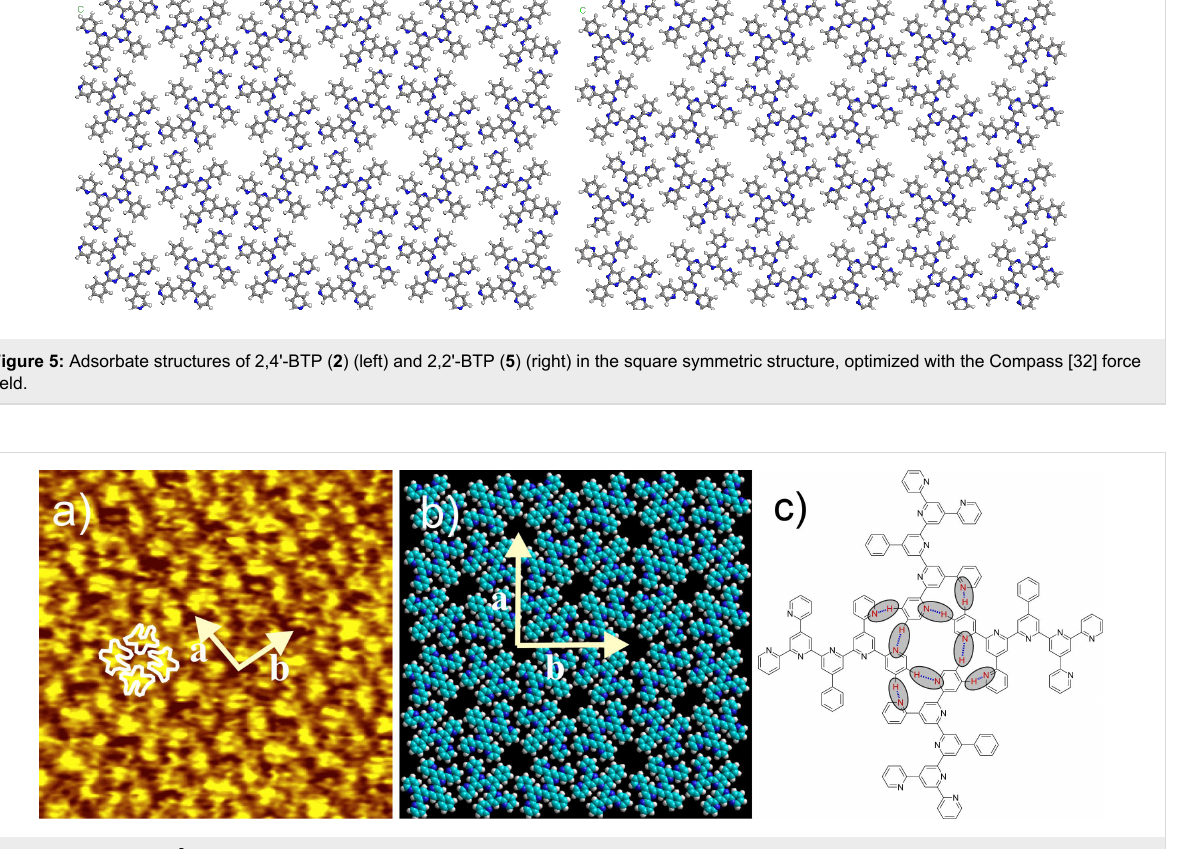
hydrogen bonding pattern gives rise to the square packing motif (Figure 6). 3,3'-BTP ( 3 ) is known to show four different 2D structures at the HOPG/TCB solution interface depending on the concentra-